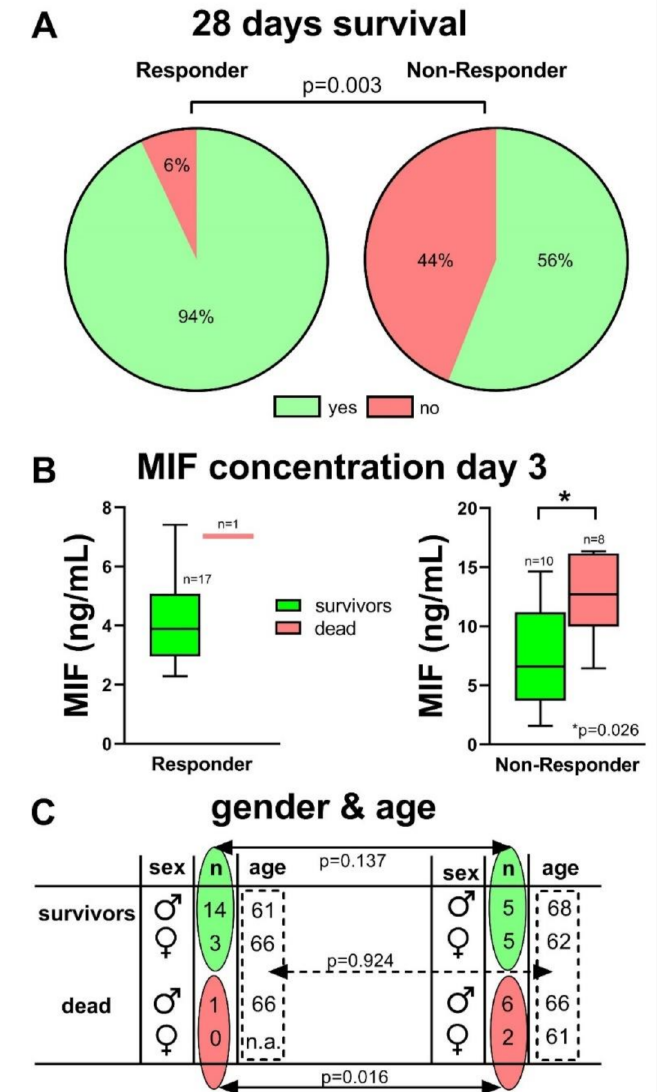
Figure 6. Significantly more COVID-19 patients survived the 28 days ICU treatment in the Responder group ( A , p = 0.003). Within the Non-Responder group, the MIF concentration on day 3 was significantly increased in patients who died compared to survivors ( p = 0.026) ( B ). There was no significant difference in gender- ( p = 0.137) and age-distribution ( p = 0.924), but none of the female patients ( n = 3) died in the Responder group, whereas 2 of 7 female patients in the Non-Responder group died during the observational period ( p = 0.0159) ( C